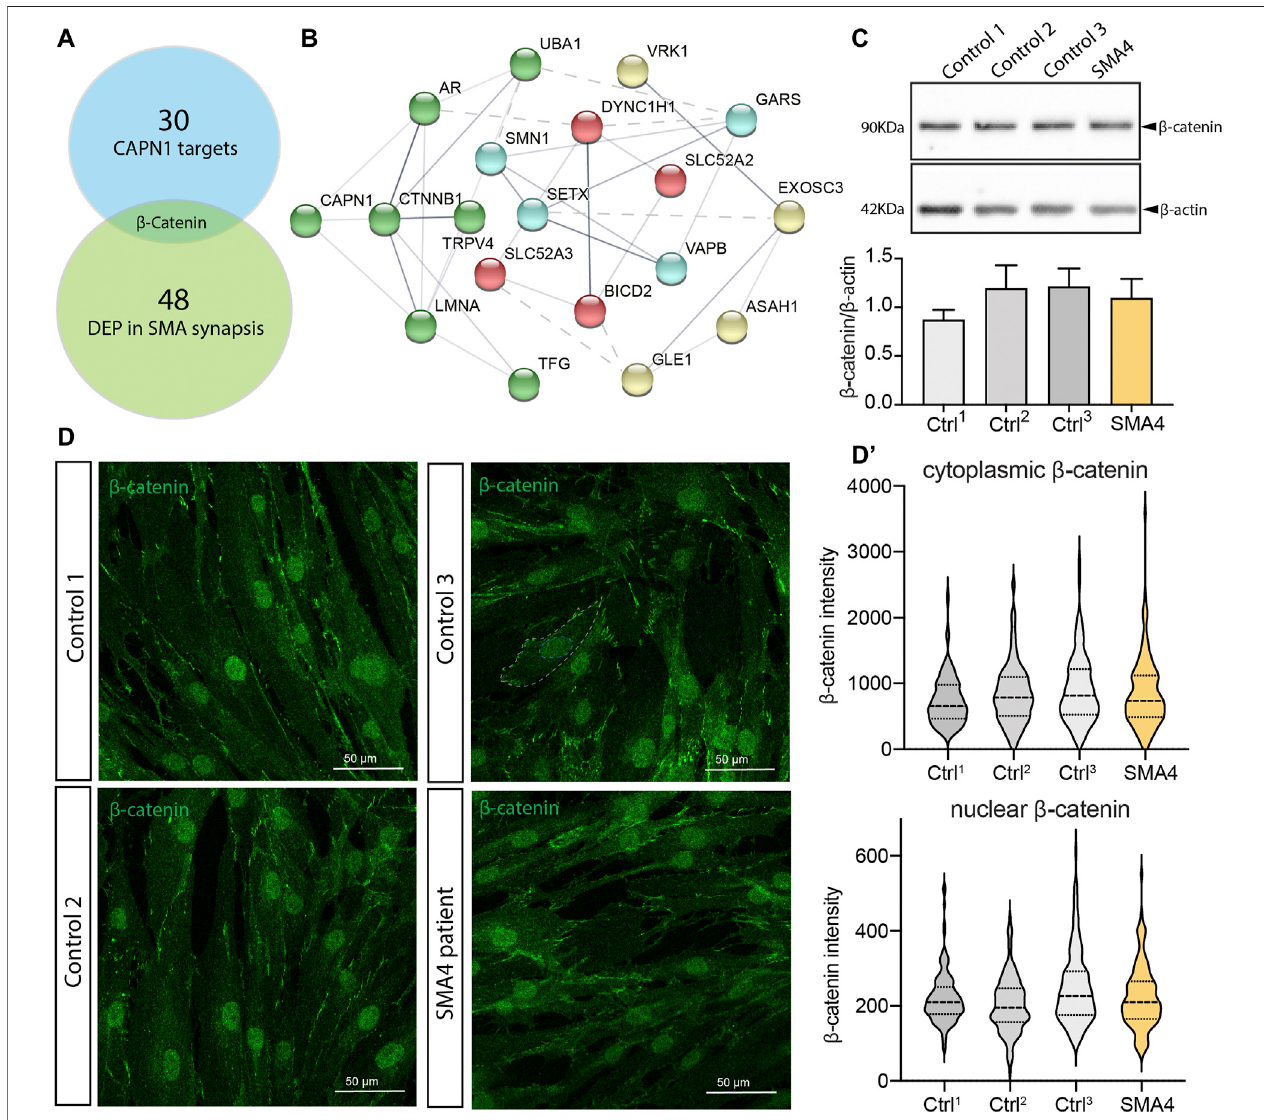
FIGURE 5 | β -catenin is not altered in SMA4 patient fi broblasts. (A) β -catenin is the only differentially expressed protein in SMA synapses that is a CAPN1 known protease target. (B) Functional protein association network of all reported SMA genes and CTNNB1 using STRING. The thickness of the network edges indicates the strength of data support. Network clusters are differentiated by colour and their connection represented by a dotted line. (C) Protein levels of β -catenin determined by western blot analysis in lysates from a SMA4 patient compared to controls fi broblasts. β -actin was used as a loading control in these experiments. The expression of β -catenin is shown in bar graphs as the mean ± SEM from 3 independent experiments. (D) Immuno fl uorescence analysis in control and SMA4-derived fi broblasts detects β -catenin (green) distribution in cytoplasmic and within the nuclei (D) . Quanti fi cation of the β -catenin cytoplasmic expression and nuclear (integrated intensity) within each cell. Violin plot shows the full distribution of all data points acquired ( n > 250